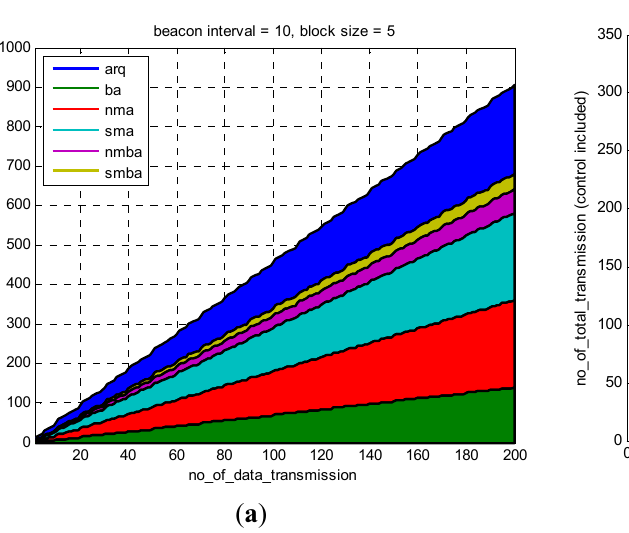
Figure 13. Number of Total Transmissions (a) variable tx interval (b) variable block size (c) variable beacon